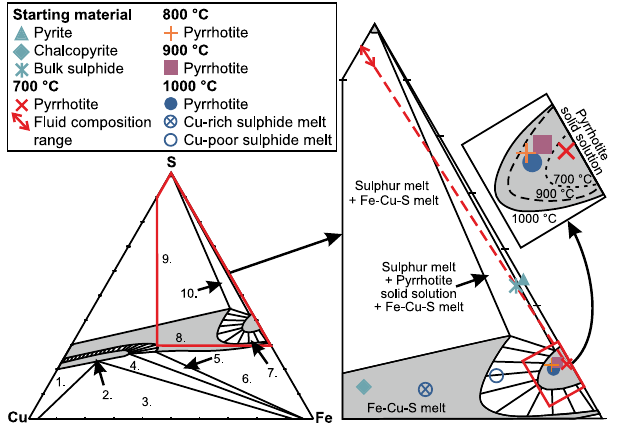
Fig. 3 Fe – Cu – S ternary diagram showing measured average sulphide compositions of the Virginia Formation black shale starting material and the experimental run products at different temperatures at 200 MPa.